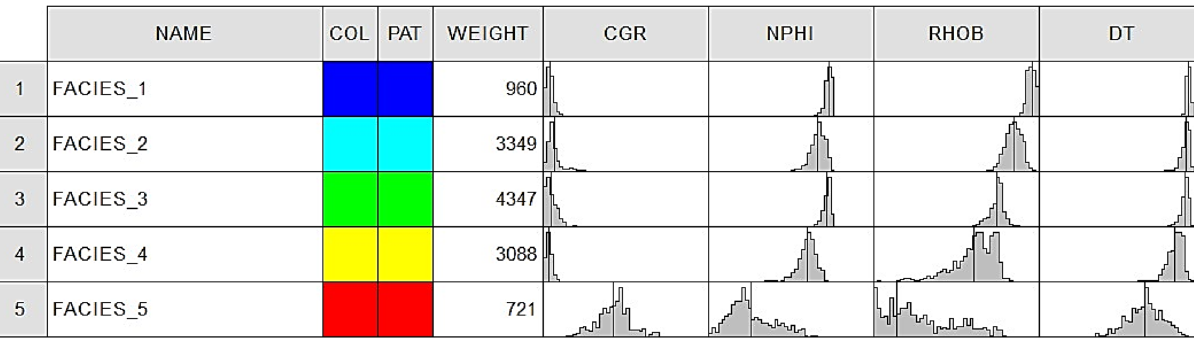
Fig. 6 The final electrofacies model of Kangan and Dalan formations with log variations and their weight, X-axis related to extending data vari- ation